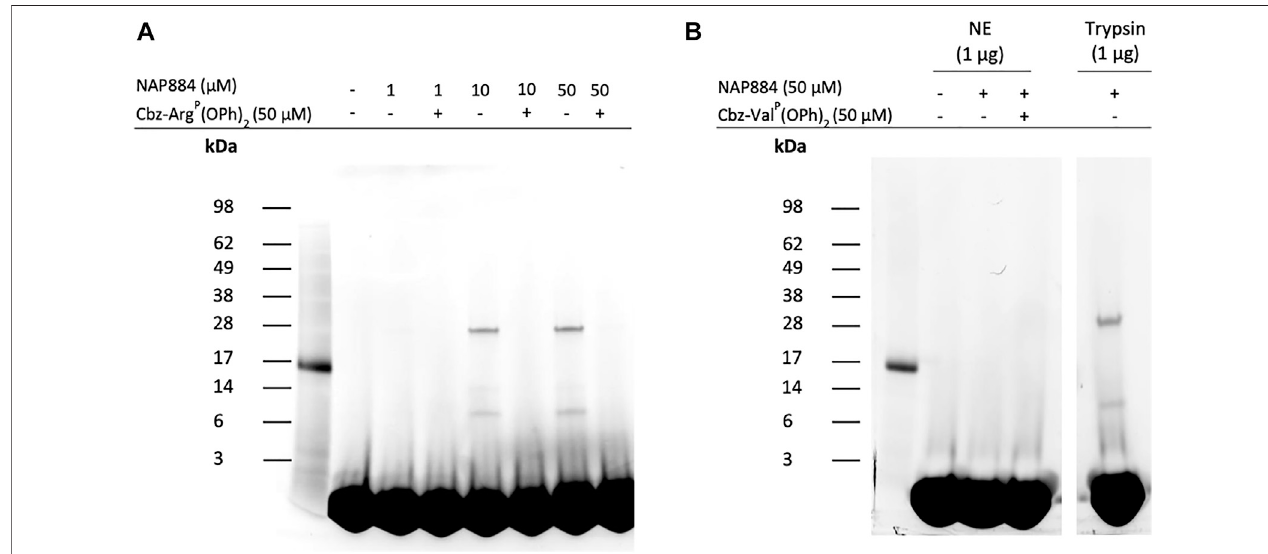
FIGURE 10 | NAP884 functions as an AP for trypsin (A) Samples of trypsin (1 μ g), were treated with varying concentrations of NAP884 (±Cbz-Arg P (OPh) 2 ), for 30 min, at 37 ° C. DMSO ( fi nal conc. 25% v/v), rhodamine-azide ( fi nal conc. 60 μ M), copper (II)-TBTA complex ( fi nal conc. 1 mM) and freshly prepared sodium ascorbate